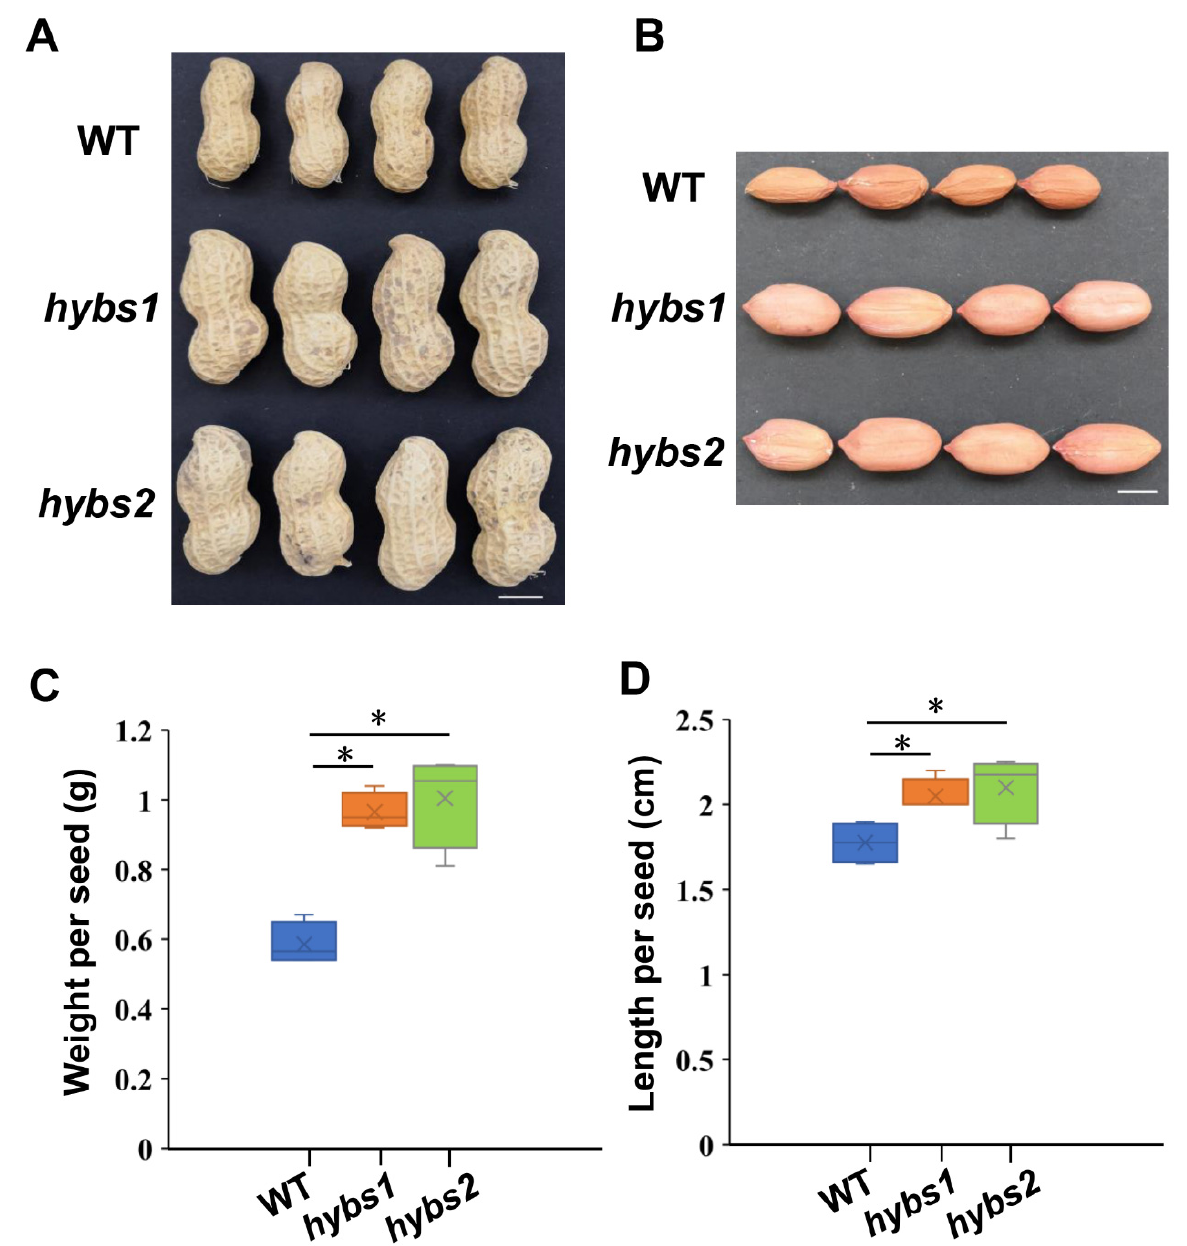
Figure 1. Isolation and characterization of hybs mutants. ( A ) Peanut pod phenotypes in hybs1 , hybs2 , and WT, Scale bars are 1 cm. ( B ) Peanut seed phenotypes in hybs1 , hybs2 , and WT, Scale bars are 1 cm. ( C ) Seed weight of matured seed of hybs1 , hybs2 , and WT. Statistically significant differences were analyzed according to four biological replicates (Mann–Whitney U -test; * p < 0.05). ( D ) Seed length of matured seed of hybs1 , hybs2 , and WT. Statistically significant differences were analyzed according to four biological replicates (Mann–Whitney U -test; * p < 0.05).